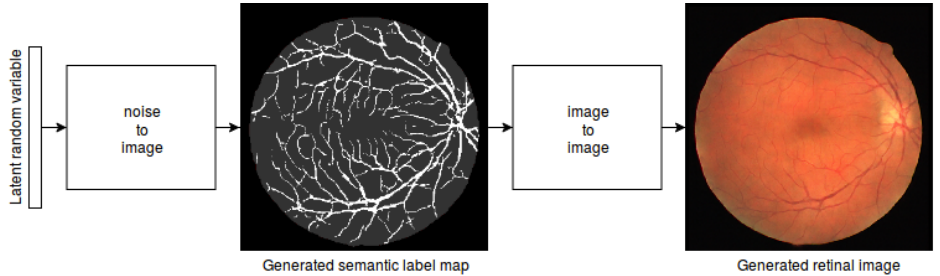
Figure 1. The proposed two-step image generation